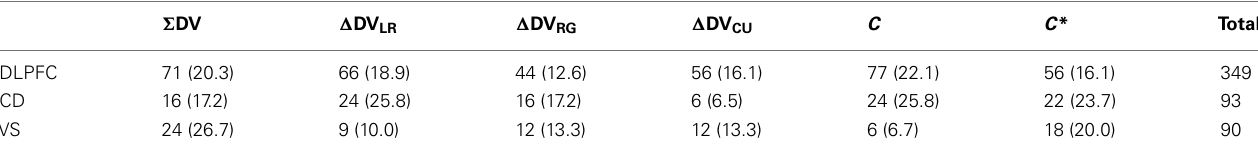
Table 1 | Number of neurons related to the animal’s choice and temporally discounted values in the DLPFC, caudate nucleus, and ventral